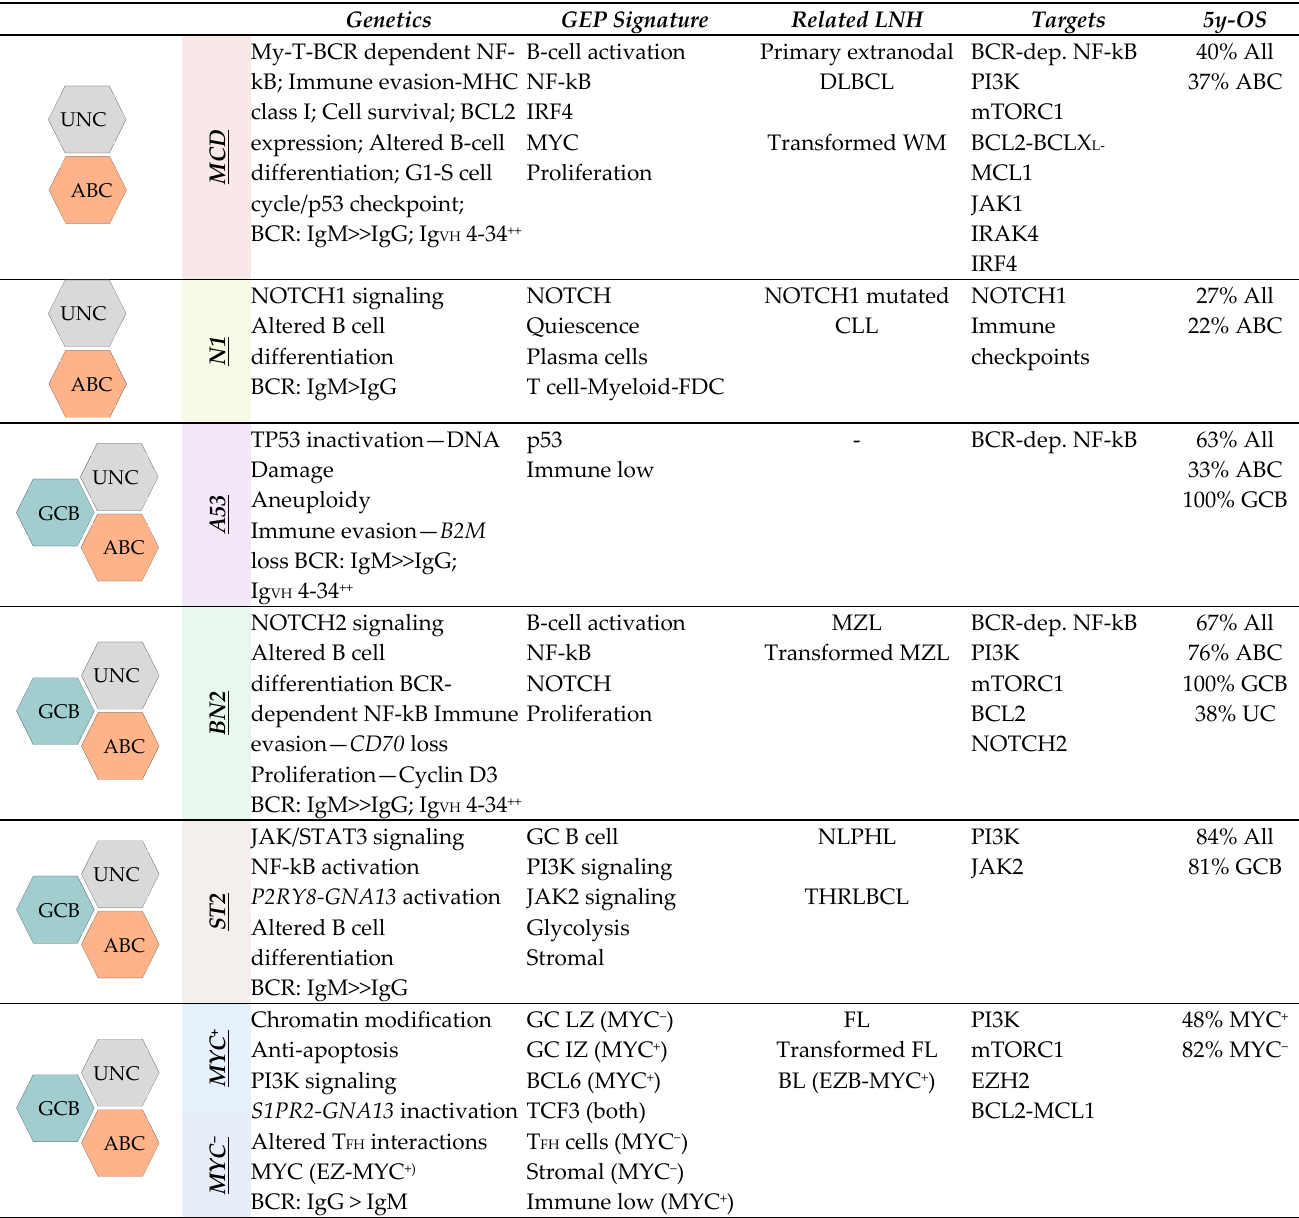
Table 3. Implications of genetic subtypes of DLBCL for therapy (from Wright et al., modified).